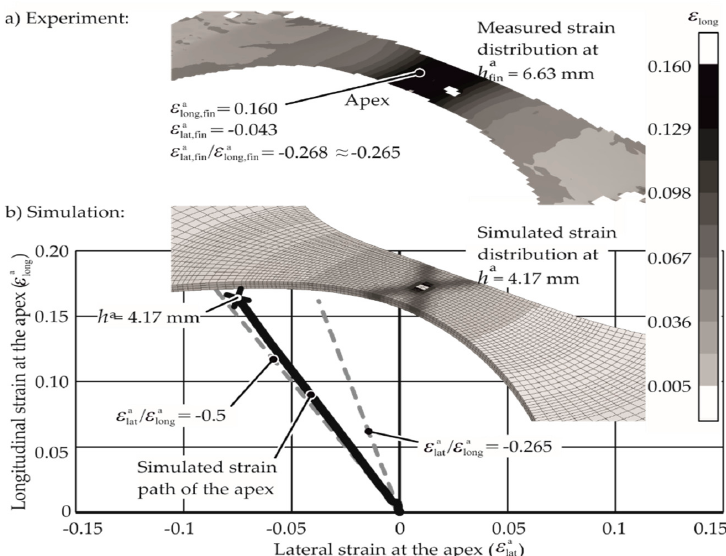
Figure 12. ( a ) Electromagnetic forming limit test with 1.0 kJ input energy, and ( b ) simulation of the same. Material: AA1050A-H24, 1 mm thick, specimen shape for uniaxial tension. h a denotes apex